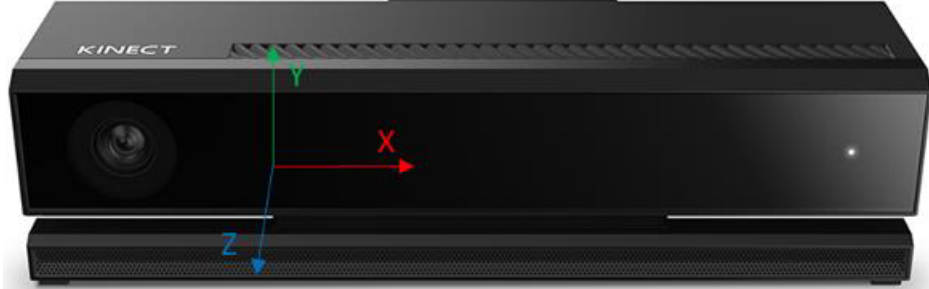
Figure 2: Kinect Sensor (reference coordinate attached)